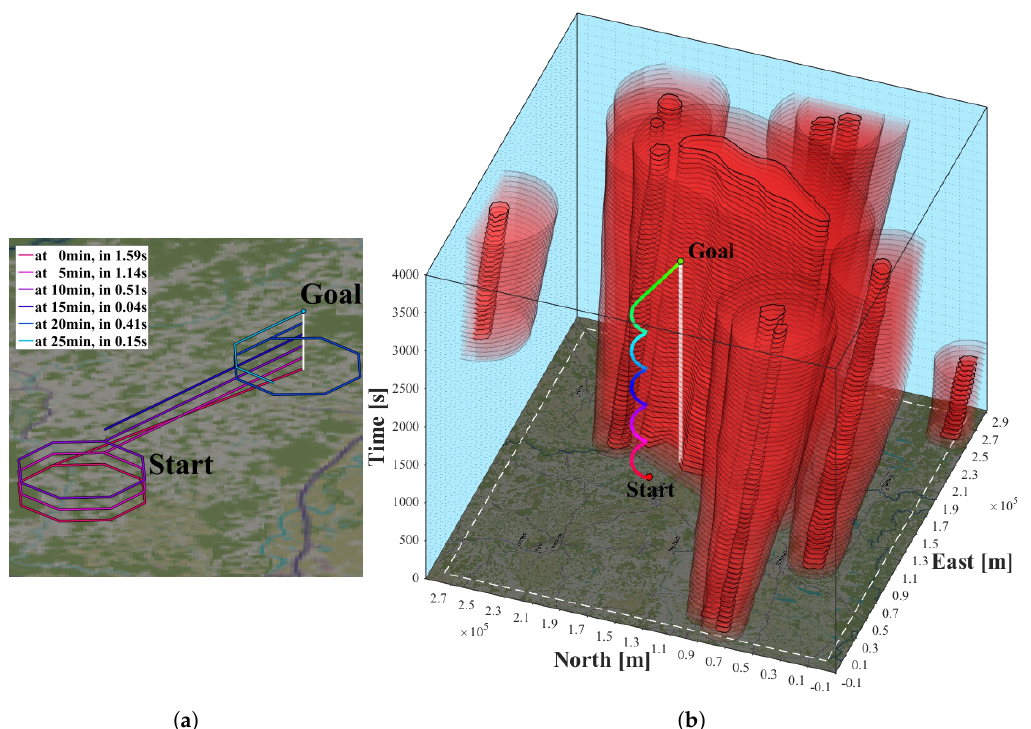
Figure 14. ( a ) Anticipatory trajectories including automatic holding patterns with runtimes for the MPTP iterations in the legend. ( b ) First iteration of the MPTP at t 0 in three dimensions. The static goal is indicated by a white line. As soon as the goal is uncovered, it is approached.